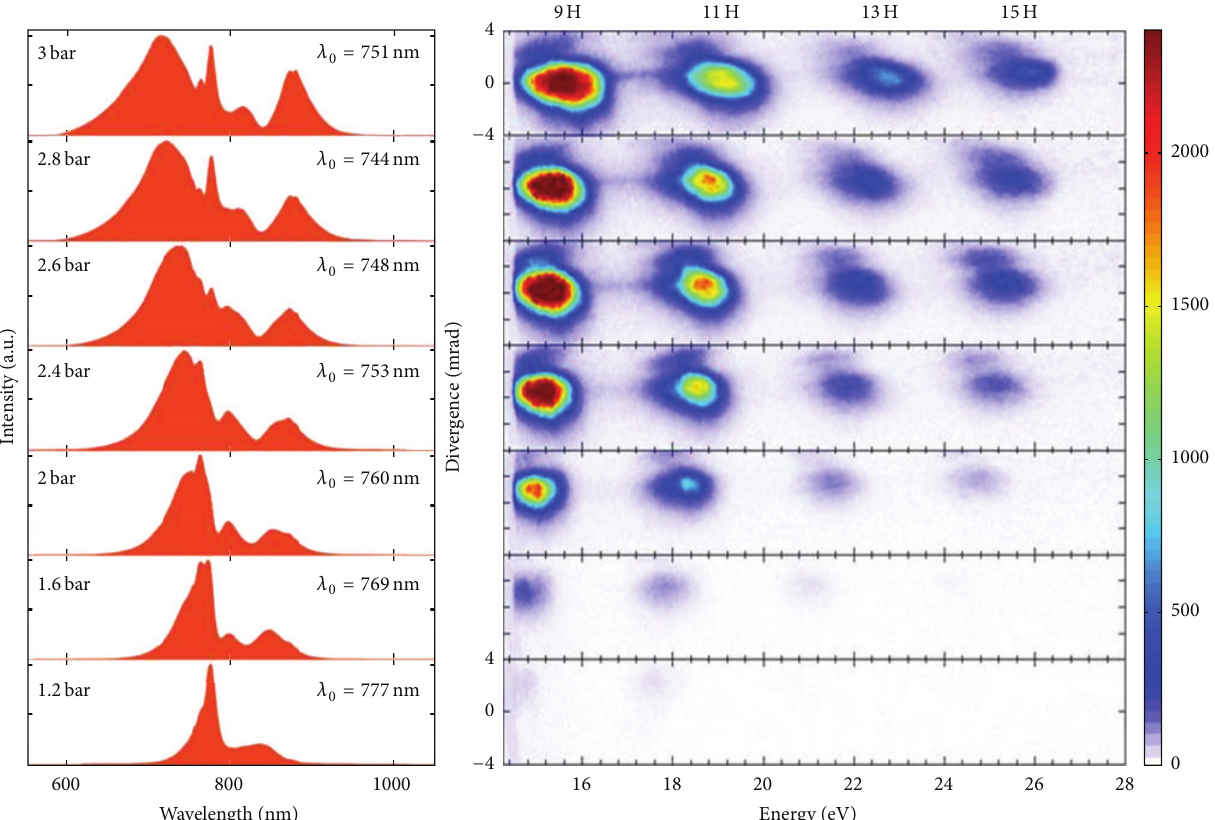
Figure9:Carbonharmonicspectraasafunctionofneonpressureinthehollowfiber.Thecorrespondingfundamentalwavespectrameasured in front of the vacuum chamber are presented on the left side. The plasma was created using the 10ns pulses. 𝜆 0 is the central weighted wavelength of the spectral distribution. The color scale indicates the harmonic intensity